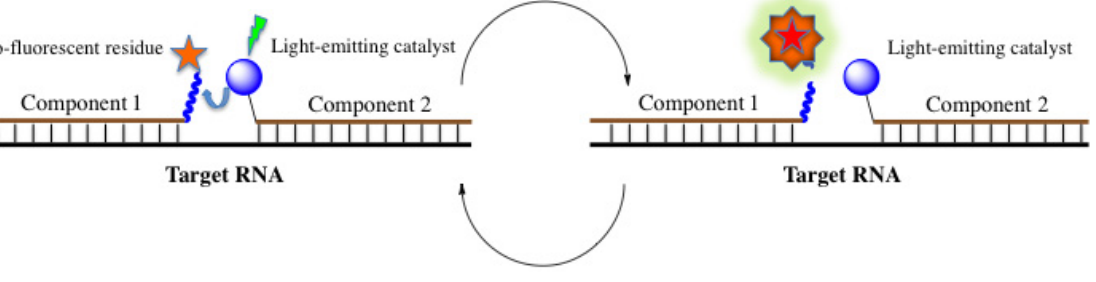
Figure 17. Template-directed light-induced catalyzed cleavage of a linker in pro-fluorophore-conjugated probe with the release of fluorescent